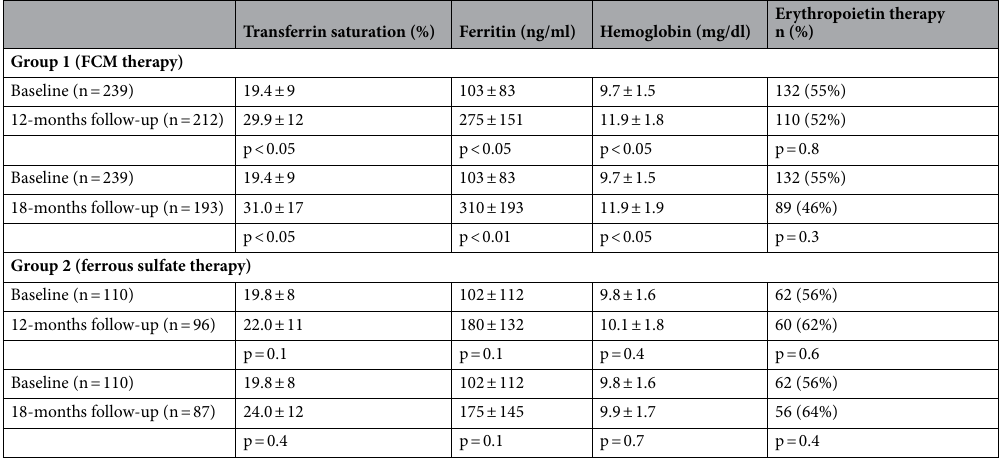
dl vs 9.8 ± 1.6 g/dl; p = 0.4), serum ferritin levels (respectively 103 ± 91 ng/ml vs 102 ± 112 ng/ml; p = 0.7), TSAT (respectively 19.4 ± 9% vs 19.8 ± 8%; p = 0.8) and eGFR (respectively 12.0 ± 4.1 vs 12.7 ± 3.9; p = 0.7). Treatment. During the 18-month treatment phase, the mean cumulative dose of iron received was 1.73 ± 0.65 g in group 1 and 84.6 ± 21.5 g in group 2. The majority of participants in group 1 (124 patients, 52%) were administered an average of 1500 mg of iron, while 43 patients (18%) received 1000 mg, and 72 patients (30%) received 2000 mg. A total of 132/239 participants (55%) in group 1 and 62/100 subjects (56%) in group 2 were treated with ESAs at baseline, with similar prescribed doses of epoietin α and darbepoetin. Treatment outcomes. At 12 months, response to treatment was observed in both groups (Table 2). In group 1, hemoglobin significantly increased from baseline after 12 months (9.7 ± 1.5 vs 11.9 ± 1.8 g/dl, p < 0.05), similarly serum ferritin (103 ± 83 vs 275 ± 151 ng/ml, p < 0.05) and TSAT (19.4 ± 9 vs 29.9 ± 12, p < 0.05); in group 2 hemoglobin (9.8 ± 1.6 vs 10.1 ± 1.8 g/dl, p = 0.4), serum ferritin (102 ± 112 vs 180 ± 132 ng/ml, p = 0.1) and TSAT (19.8 ± 8 vs 22.0 ± 11, p = 0.1) increased without reaching significance. At 18 months, in patients from group 1 hemoglobin (9.7 ± 1.5 vs. 11.9 ± 1.9 g/dl, p < 0.05), serum ferritin (103 ± 83 vs 310 ± 193 ng/ml, p < 0.01) and TSAT (19.4 ± 9 vs 31.0 ± 17, p < 0.05) still improved. Conversely, in patients from group 2 no significant further increase in hemoglobin (9.8 ± 1.6 vs. 9.9 ± 1.7 g/dl, p = 0.7), serum ferritin (102 ± 112 vs 175 ± 145 ng/ml, p = 0.1) and TSAT (19.8 ± 8 vs 24.0 ± 12, p = 0.4) was recorded and the concentrations remained comparable to the values reached at 12 months (Table 2). In addition to this, ESAs utilization decreased in group 1, considering the number of treated patients and prescribed doses: at 18 months, comparing the two groups, group 1 showed a significant reduction of treated patients vs group 2 (respectively 89/193 vs 56/87 subjects, p < 0.01), epoietin α dose (3500 ± 1563 vs 5672 ± 2145, p < 0.05) and darbepoetin dose (14.9 ± 4.95 vs 26.4 ± 11.0, p < 0.05) (Table 3).